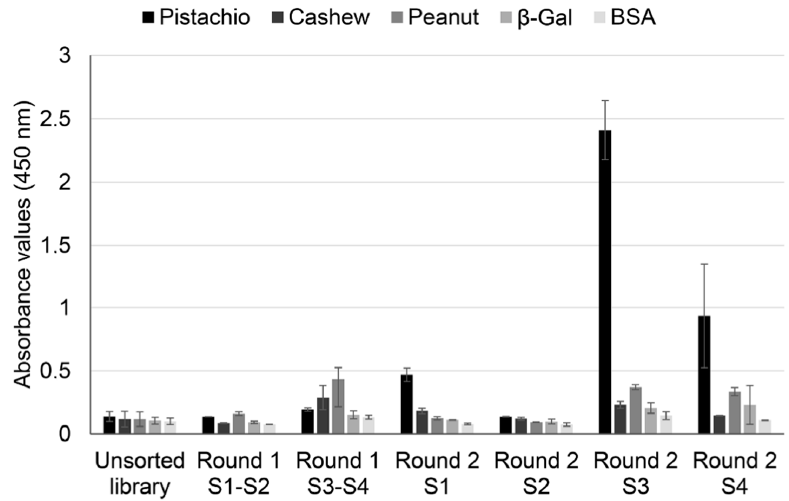
Figure 2. Indirect phage-dAb ELISA results obtained with polyclonal phages rescued at each round of selection from strategies S1–S4 against pistachio. Precipitated phages from each round of selection were analysed against pistachio, cashew and peanut extracts and negative controls (beta-galactosidase and BSA). Absorbance values are the mean of three independent experiments with duplicates. Error bars show the standard deviation for each set of data.